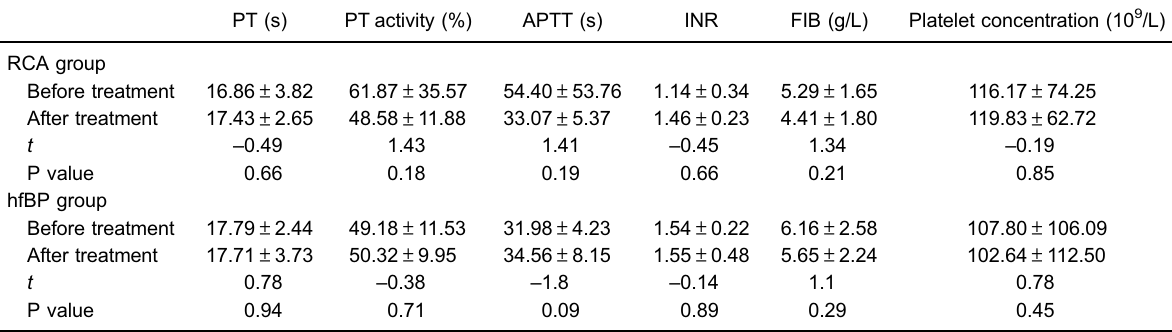
Table 2. Coagulation indicators at baseline and after continuous blood puri fi cation within regional citrate anticoagulation (RCA) or heparin-free blood puri fi cation (hfBP) groups.